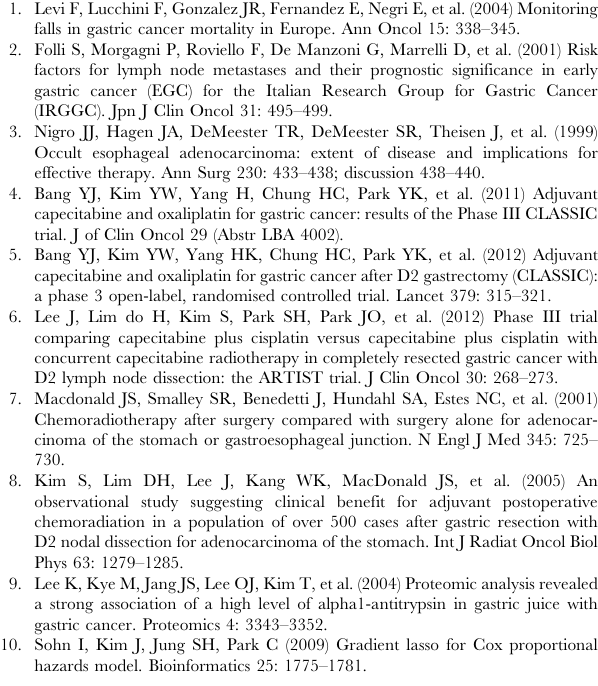
treated with surgery only. a. Figure S9 . DFS of stage II patients treated with chemoradiotherapy based on quartile of GCPS-g2. b. Figure S10 . DFS of stage II patients treated with surgery alone based on quartile of GCPS-g2. c. Figure S11 . Expression of adverse prognostic genes included in Gastric Cancer Prognostic Score according to tissue compartments (tumor versus stroma). Normalized expression levels are shown. d. Table S8 . List of nCounter probes included in GCPS-g2. 8. Gastric cancer validation study protocol. a. Figure S12 . Gastric cancer validation study